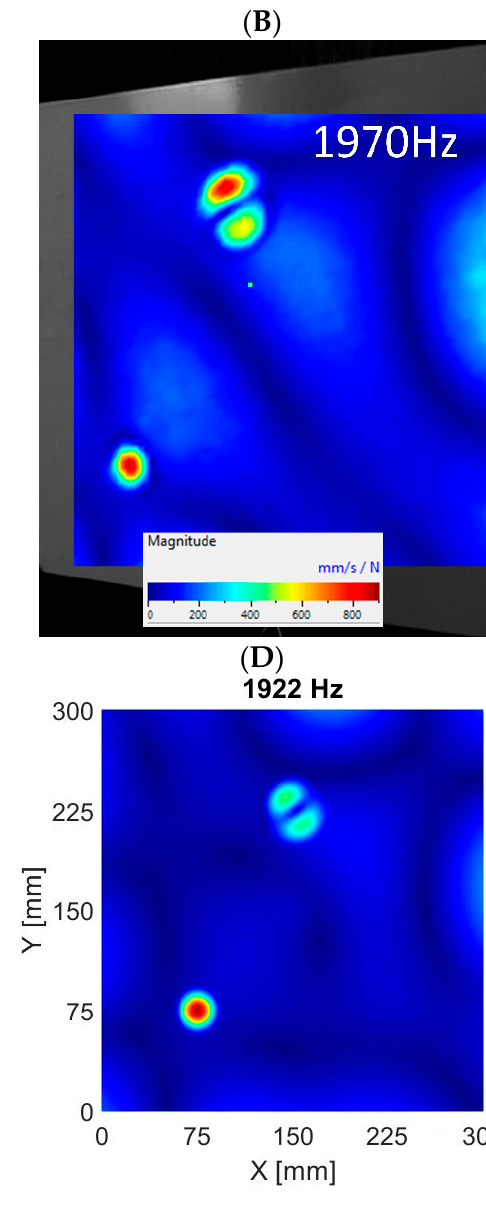
Figure 9. Visualization of out-of-plane vibrations—FBH Ø58 mm. The first LDR in experimental data ( A ) and numerical results based on the 3D FE model ( C ). The second LDR in experimental data ( B ) and numerical results based on the 3D FE model ( D ).